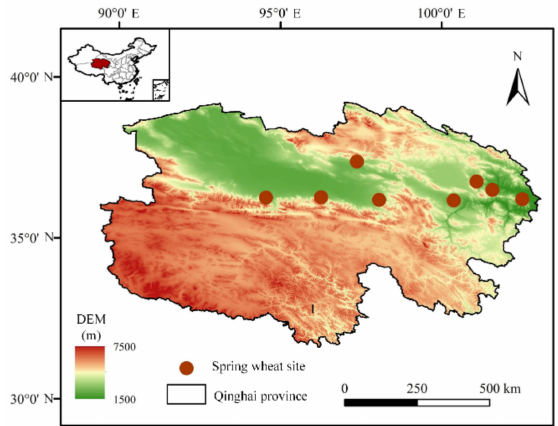
Figure 1. Spatial distribution of elevation and spring wheat sites in Qinghai of China.